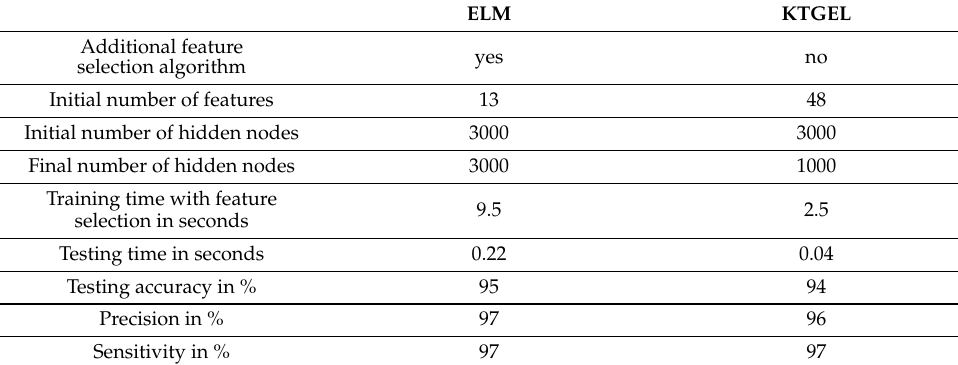
Table 4. Comparison between the ELM and KTGEL in recognition of ASL signs with a middle ambiguity level.